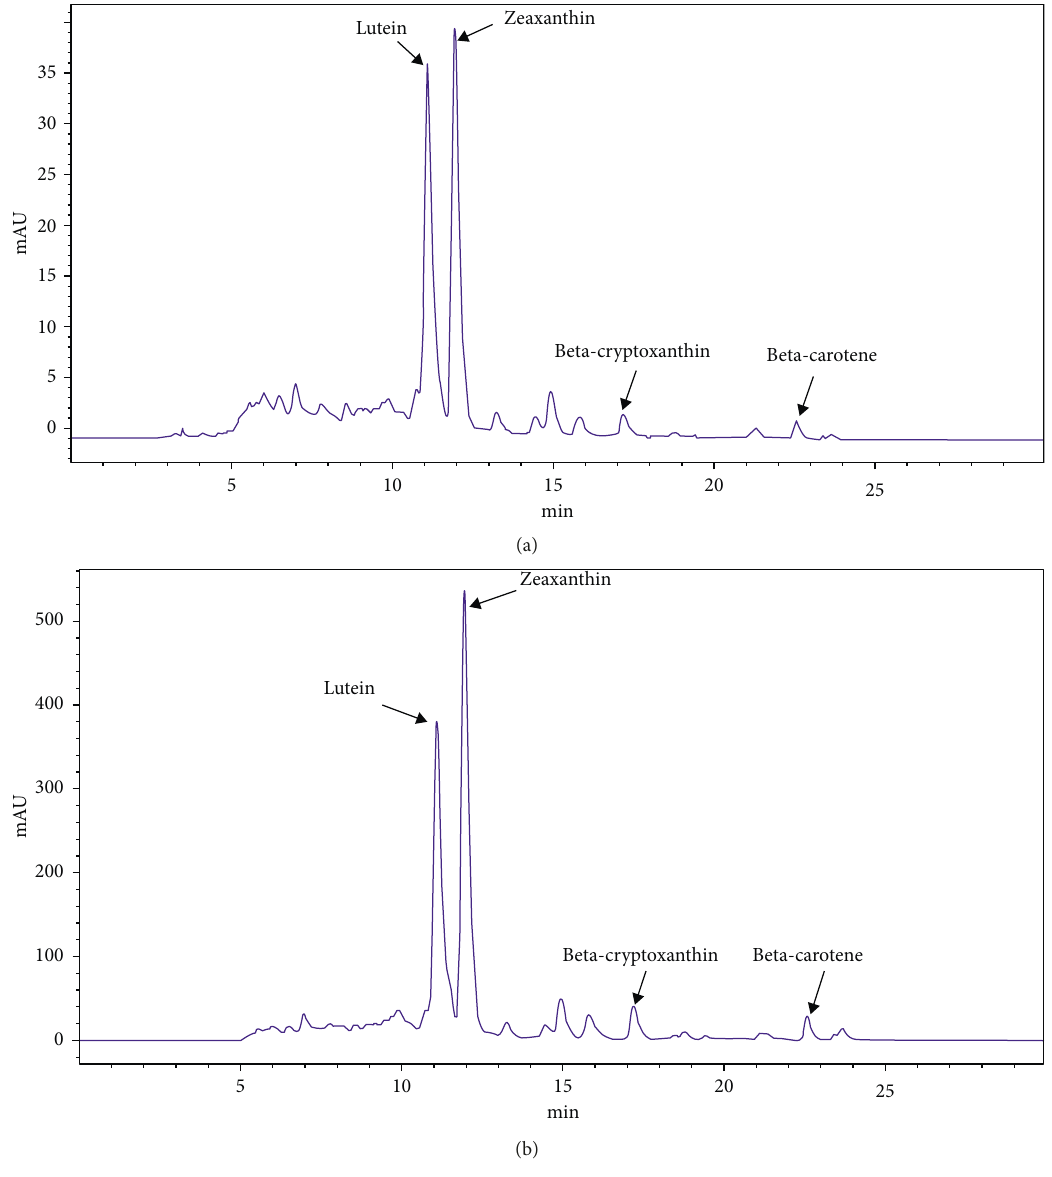
Figure 1: HPLC analysis of major carotenoid compounds of CGM. (a) No pretreatment; (b) freeze-thaw